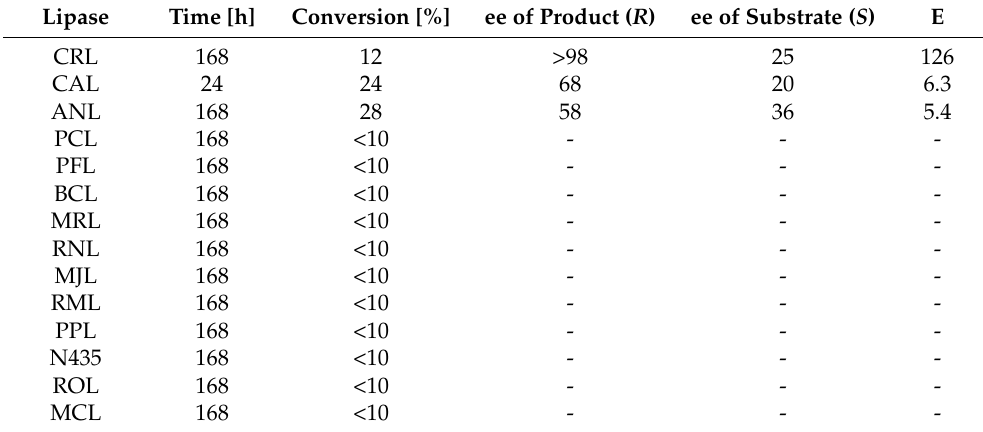
Table 1. Lipase-catalyzed hydrolysis of dimethyl 1-butyryloxy-1-carboxymethylphosphonate 2a .